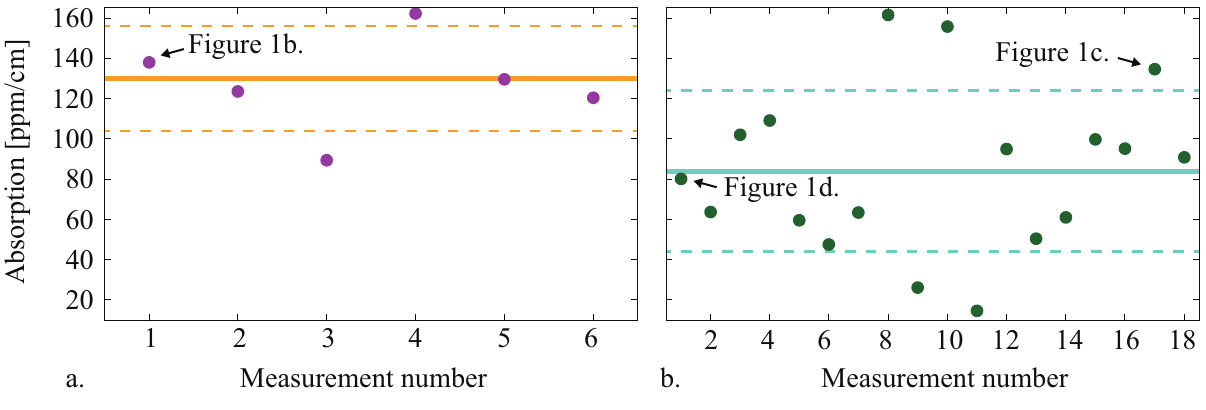
Figure 2. The dots show the absorption coefficient obtained from individual measurements at 775 nm (left) and at 1,550 nm (right). The mean value (line) and standard deviation (dashed lines) of the absorption coefficient are α 775nm = 127 ± 24 ppm / cm and α 1 = 84 ± 40 ppm / cm . The absorption results corresponding to the peaks shown in , 550nm Figure 1 are labeled.